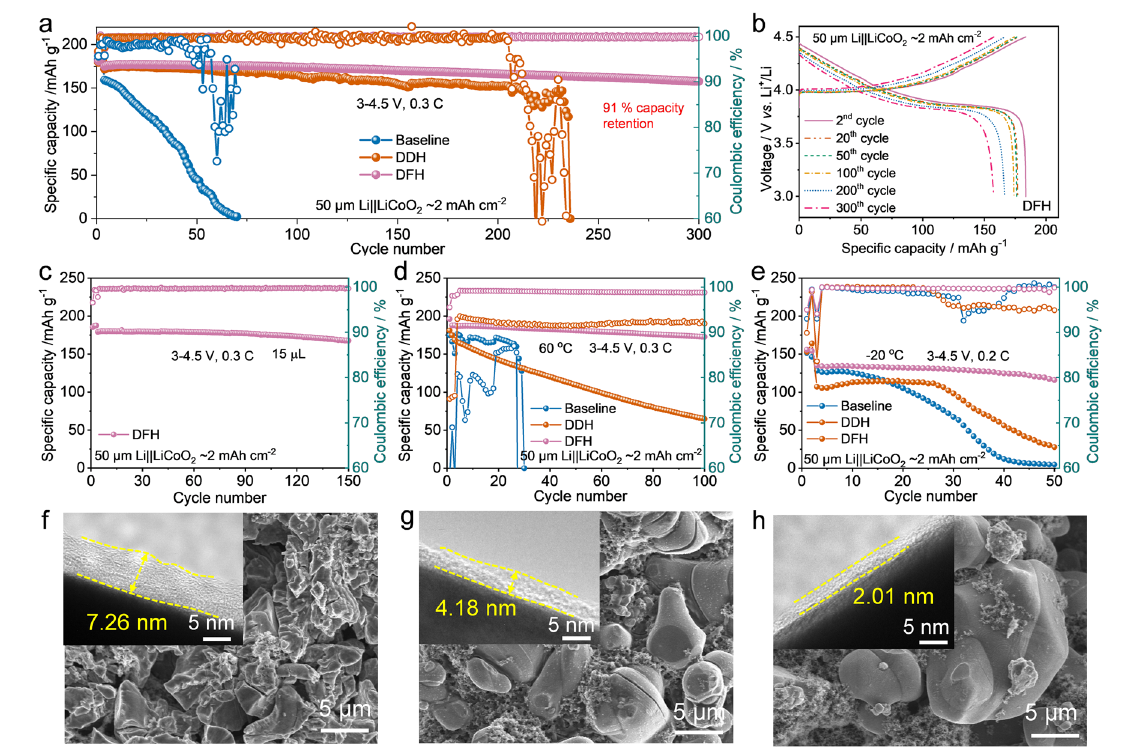
Fig. 4 Cyclic performances of Li||LiCoO 2 full batteries and LiCoO 2 cathode morphology after cycling. a Long-term cycling performance of Li||LiCoO 2 cells using baseline, DDH, and DFH electrolytes. b Charge–discharge voltage profiles of a Li||LiCoO 2 cells employing DFH elec- trolyte at different cycles. c Cycling performance of Li||LiCoO 2 cells using DFH with 15 μL electrolyte. Cycling performance of Li||LiCoO 2 cells using baseline, DDH, and DFH electrolytes at d 60 °C and e − 20 °C. FE-SEM and TEM images of LiCoO 2 cathode cycled in f baseline, g DDH, and h DFH electrolytes for 50 cycles at